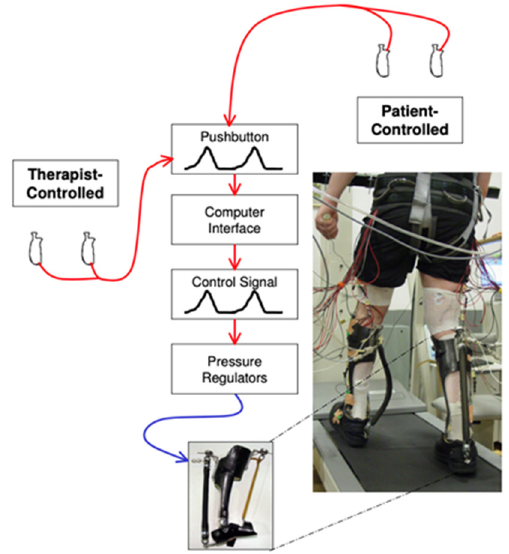
Figure 5. University of Michigan’s Powered Ankle-Foot Orthotic system. Hand-held pushbuttons are activated by the therapist or patient, generating a voltage proportional to the press. This in turn controls plantarflexion torque. Reprinted with permission from [74].Copyright 2006 BMC.